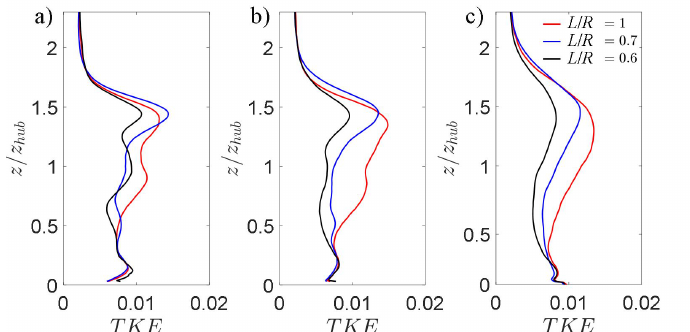
Figure 8. Profiles of the turbulence kinetic energy, TKE = (cid:104) u (cid:48) 2 + w (cid:48) 2 (cid:105) /2 U 2 rotors L / R = 0.6, 0.7 and 1 at x / d T = ( a ) 2.6, ( b ) 3.8 and ( c )